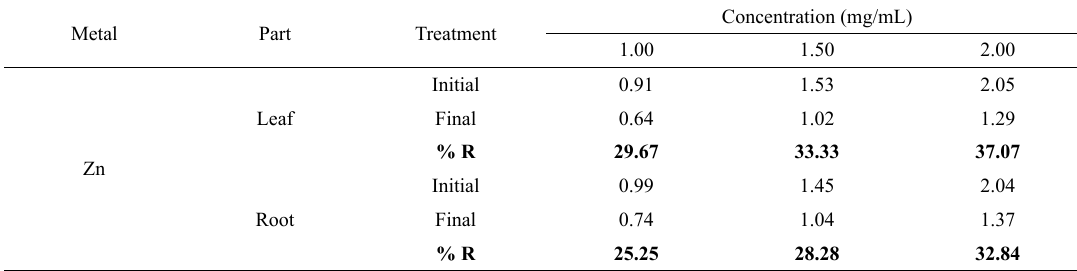
Table 1. Zinc metal removal percentage of the initial and final concentrations of treatments for leaf and root.